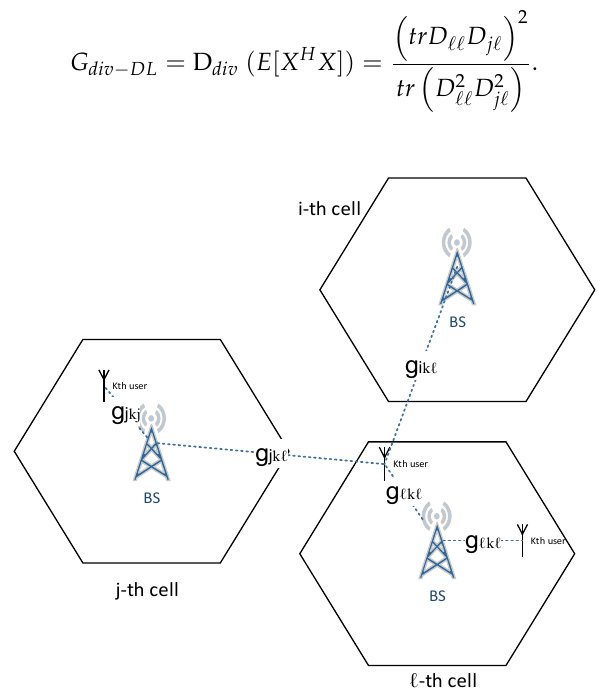
Figure 3. Interference due to pilot contamination at the downlink channel.